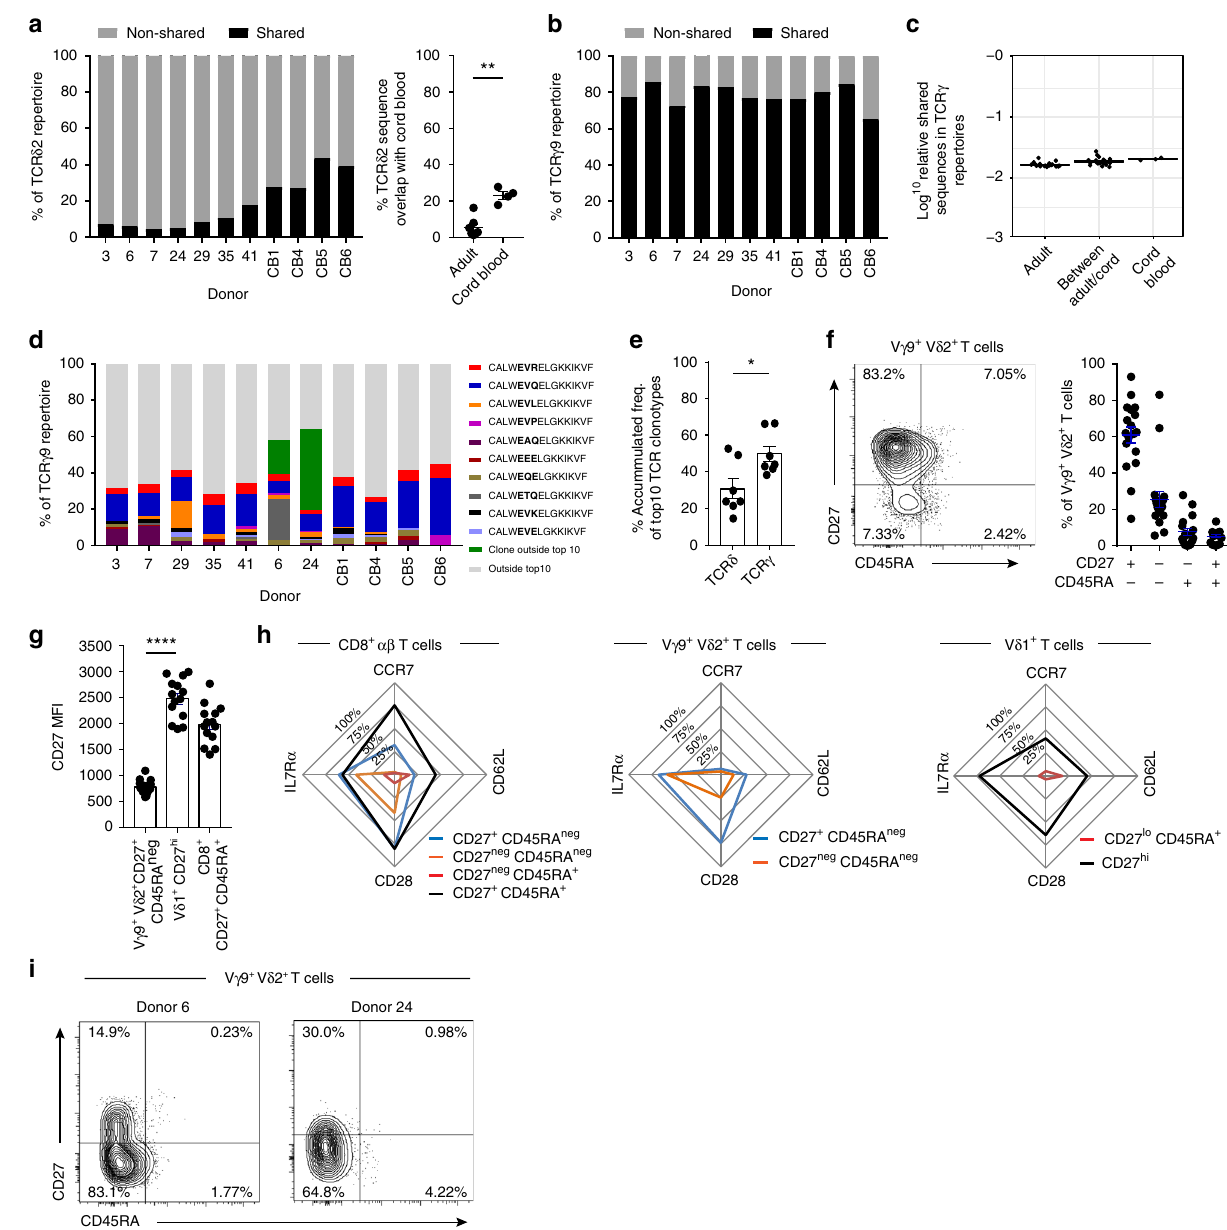
Fig. 2 V δ 2 + TCR repertoires are formed of public clonotypes. a Percentage of CDR3 δ sequences (amino acid) shared between > 2 donors within both adults and cord blood (left) and sequences shared with cord blood only (right). b Percentage of CDR3 γ 9 sequences (amino acid) shared between >2 donors (public sequences). c Comparison of the sequence overlap (relative publicity) of TCR γ 9 repertoires in adult peripheral blood donors ( n = 7) or cord blood samples ( n = 3) and then between both groups. d Frequency of each of the 10 most common clonotypes in each donor ’ s TCR γ 9 repertoire, with the addition of exceptional expanded shared clonotypes usually found outside the top 10 (dark green). e Comparison of the accumulated repertoire frequency occupied by the fi rst 10 clonotypes in V δ 2 + TCR δ and γ ( n = 7). f CD27 and CD45RA T-cell memory marker expression by V γ 9 + V δ 2 + T cells from adult peripheral blood samples ( n = 18). g Comparison of CD27 expression levels (MFI) on CD27 + CD45RA neg V γ 9 + V δ 2 + T cells ( n = 18), CD27 hi V δ 1 + ( n = 14) and CD27 + CD45RA + CD8 + T cells ( n = 14) from adult peripheral blood samples. h Summary radar plot data detailing the mean % positive cells for each indicated T-cell marker analysed within each sub-population of V γ 9 + V δ 2 + ( n = 18), V δ 1 + ( n = 14) and CD8 + αβ T cells ( n = 14). i Healthy adult peripheral blood donor 6 and 24 ’ s expression of CD27 and CD45RA T-cell memory markers on V γ 9 + V δ 2 + T cells. Error bars indicate means ±